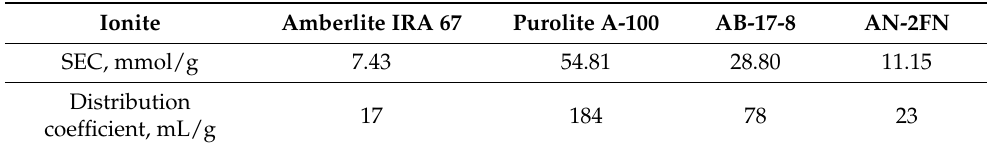
Table 2. Values of SEC and niobium distribution coefficient of anion-exchange resins of vari- ous